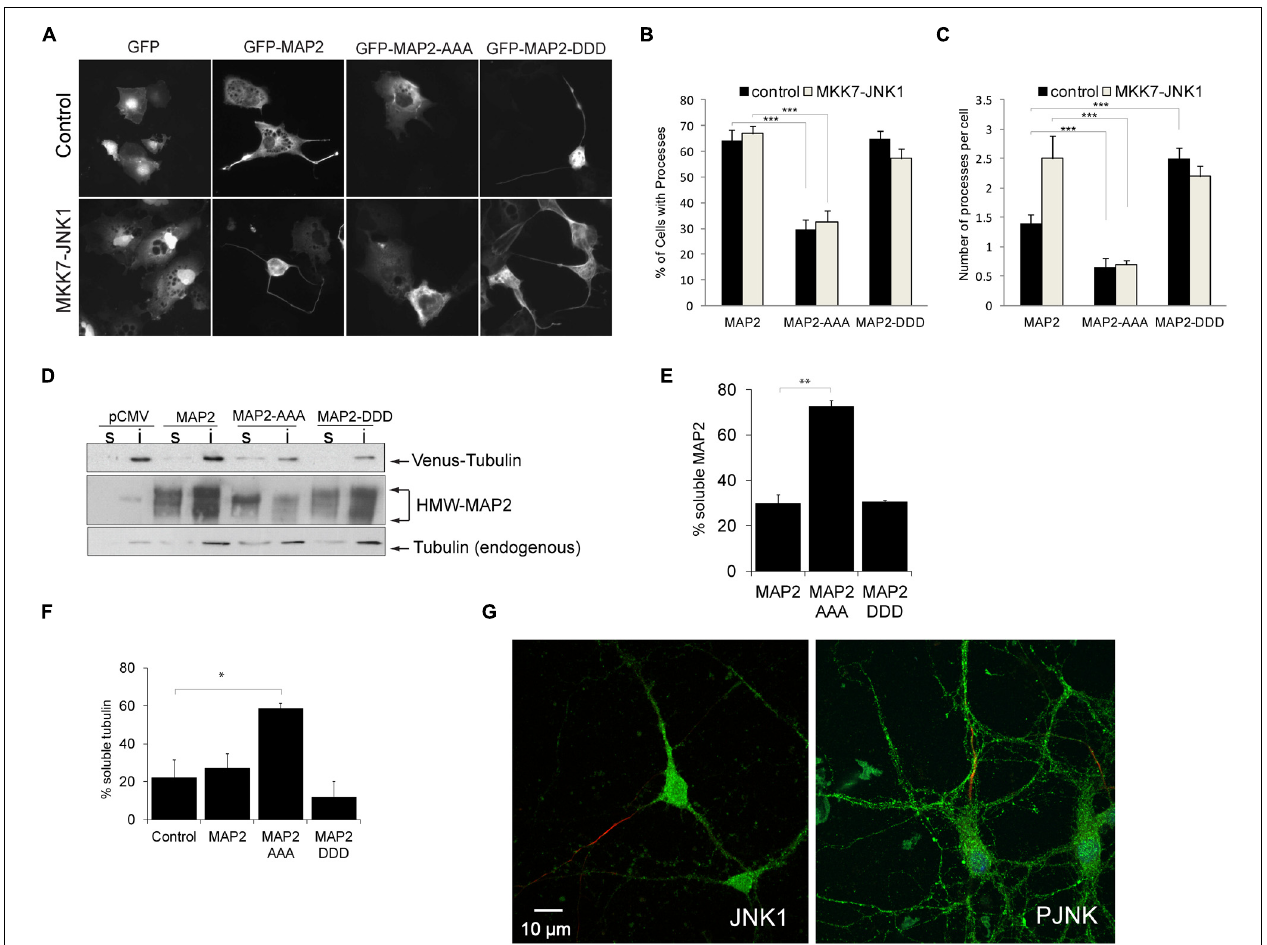
FIGURE 2 | PRD phosphorylation of MAP2 is necessary and sufficient for microtubule stabilization and MAP2-induced protrusion growth. (A) COS-7 cell were transfected with GFP, GFP-MAP2, GFP-MAP2 T1619D,T1622D,T1625D (henceforth GFP-MAP2-DDD), or GFP-MAP2 T1619A,T1622A,T1625A (henceforth GFP-MAP2-AAA), with or without MKK7-JNK1 as shown. GFP-MAP2-induced protrusion growth while MKK7-JNK1 alone did not. (B) The proportion of cells that generated processes upon 48 h expression of MAP2 variant is shown. GFP-MAP2-AAA expressing cells failed to produce protrusions. (C) The number of processes per cell was counted. Expression of MKK7-JNK1 augmented the number of MAP2-generated processes. GFP-MAP2-DDD alone induced significantly more processes than did GFP-MAP2. (D) Fibroblasts transfected with Venus-tubulin together with GFP, GFP-MAP2, GFP-MAP2 T1619A,T1622A,T1625A (MAP2-AAA), or